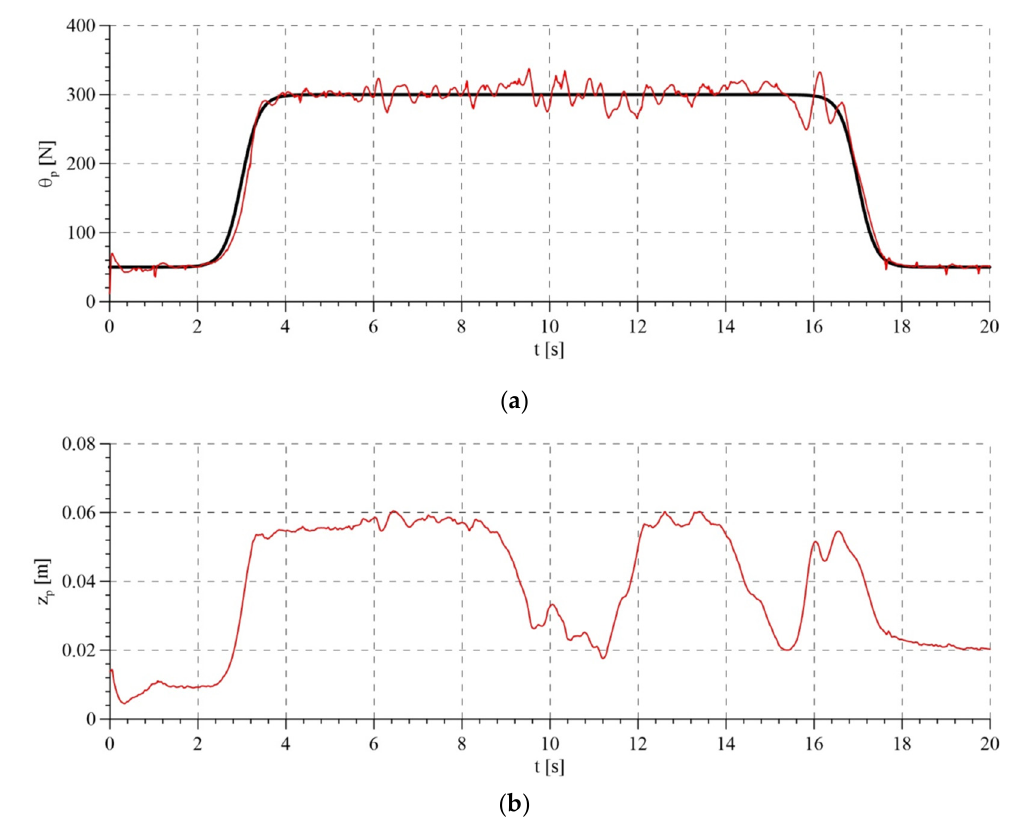
Figure 17. Results of experimental research: ( a ) set and realized rope reaction force with the use of the adaptive algorithm; ( b ) displacement of human torso.